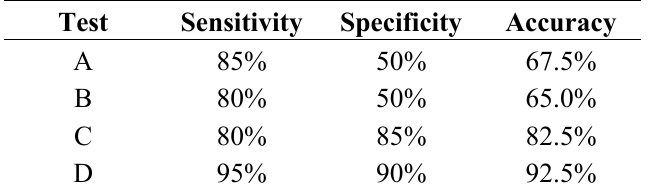
Table 3. Summarized results of the discriminated groups cannabis users and tobacco smokers (Test A is performed by first using two principal odor components made apparent from sensor curves and traditional linear discriminant analysis, Tests B, C and D are performed using extracted indices from the sensor curves; test B uses PCA and LDA, test C uses SDA and test D uses SVM for classification and discrimination purposes).